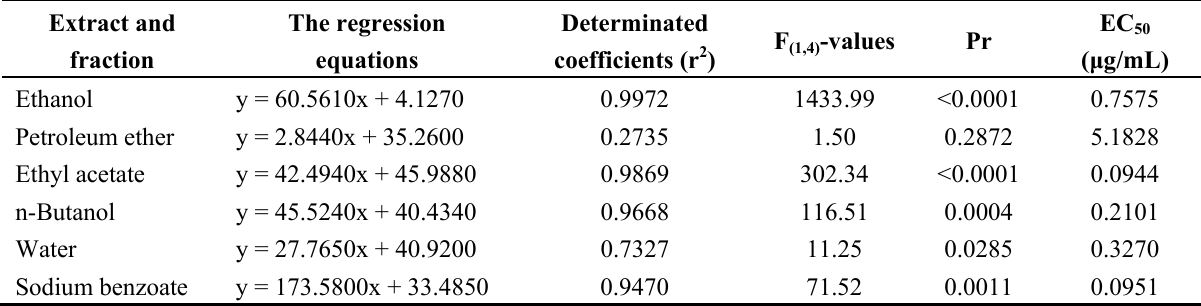
Table 3. The regression equations of the hydroxyl-radical scavenging rate on the sample concentration and the EC values. 50